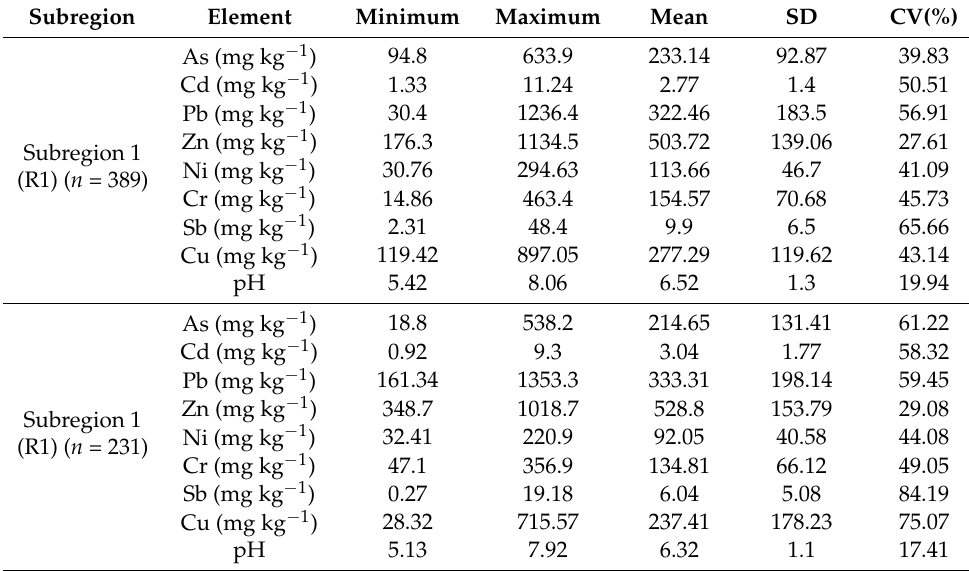
Table 1. Descriptive statistics of the soil heavy